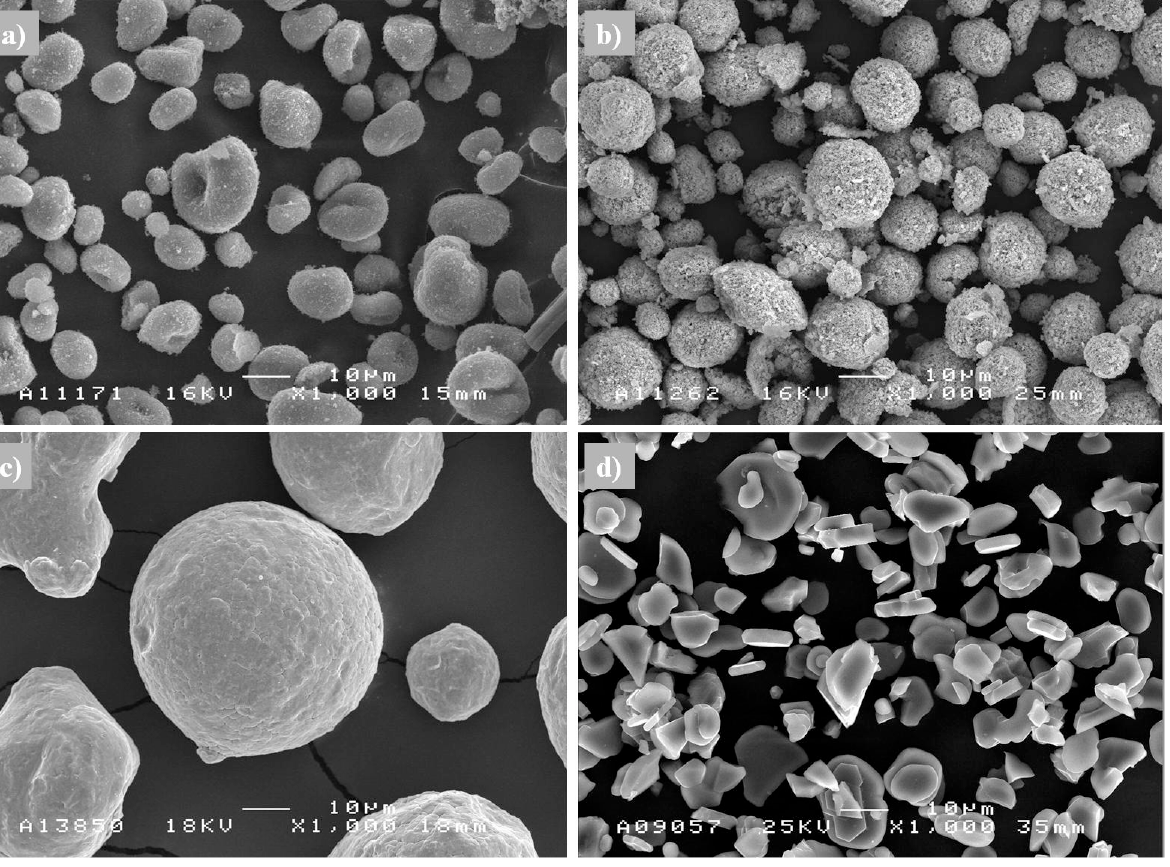
Figure 9. SEM images of thermal spray powders representing different morphologies. a ) Ball mill mixed, agglomerated and sintered Al atomized Ni20Cr; and d ) fused and crushed Al